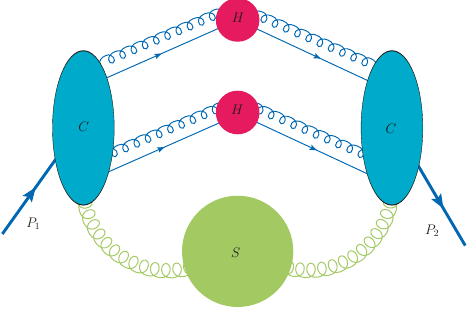
Figure 2 . The leading-power reduced diagram for the large-momentum form factor F of a meson. Two H denote the two hard cores separated in the transverse space by ~b diagrams and S denotes the soft sub-diagram. It should be noted that for TMD factorization the separation of collinear and soft contribution can be achieved, however, there is no equivalence between the collinear modes and